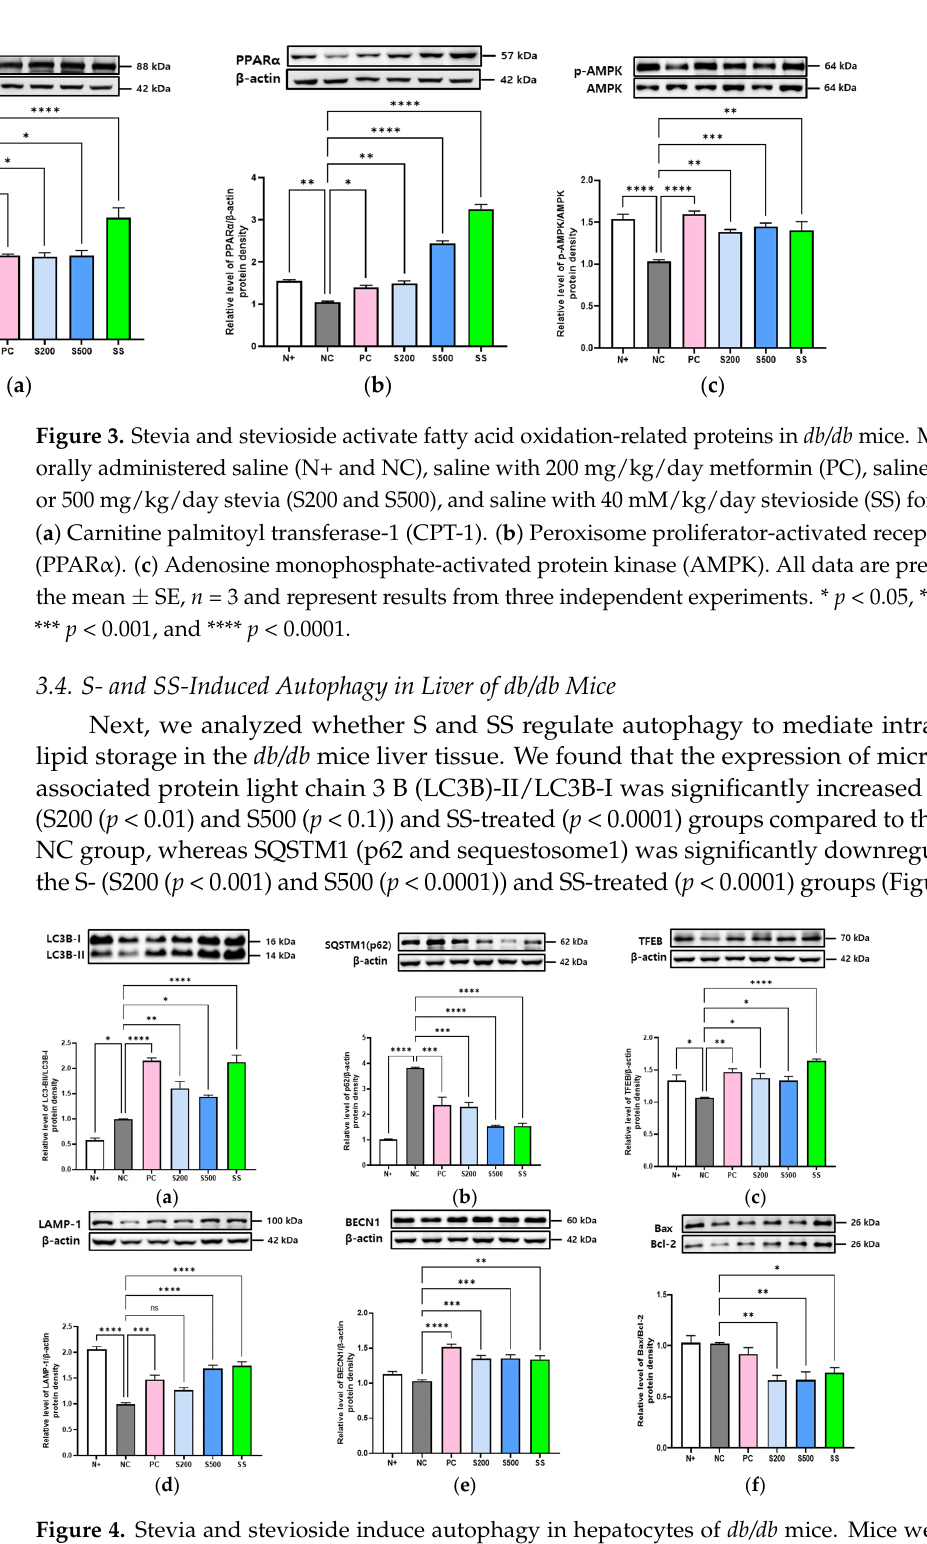
( h ) Figure 2. Stevia and stevioside attenuate adipogenic-related genes and proteins in db/db mice. Mice were orally administered saline (N+ and NC), saline with 200 mg/kg/day metformin (PC), saline with 200 or 500 mg/kg/day stevia (S200 and S500), and saline with 40 mM/kg/day stevioside (SS) for 3 weeks. ( a , e ) Peroxisome proliferator-activated receptor gamma (PPAR γ ). ( b , f ) Sterol regulatory element-binding transcription factor-1c (SREBP-1c). ( c , g ) CCAAT/enhancer binding protein alpha (C/EBP α ). ( d , h ) Fatty acid synthase (FAS). All data are presented as the mean ± SE, n = 6 and repre- sent results from three independent experiments. * p < 0.05, ** p < 0.01, *** p < 0.001, and **** p < 0.0001. 3.3. S and SS Activated Lipid Metabolism and AMPK Phosphorylation in db/db Mice